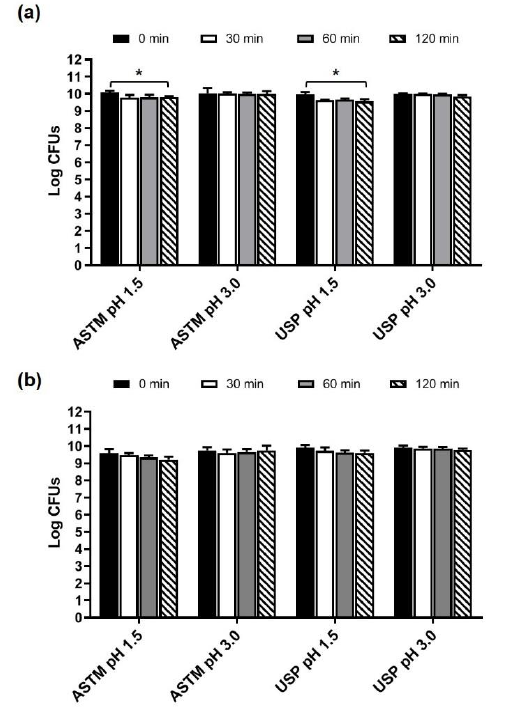
Figure 1. Survival of microorganisms contained in Microbiosys ( a ) and Enterogermina Viaggi ( b ) in the ASTM- and USP-simulated gastric fluids at pH 1.5 and 3.0. Microbial counts were carried out at 0, 30, 60, and 120 min of incubation and expressed as Log CFUs. * p <